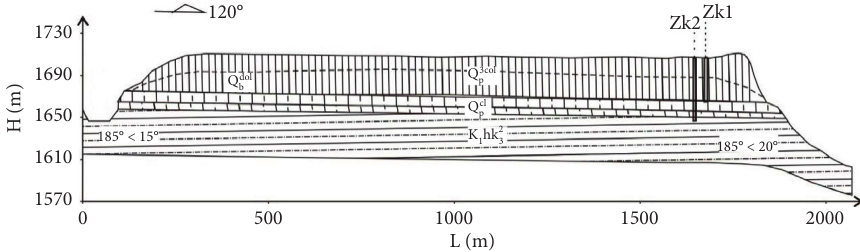
Figure 5: The hydrogeological model for the Heifangtai